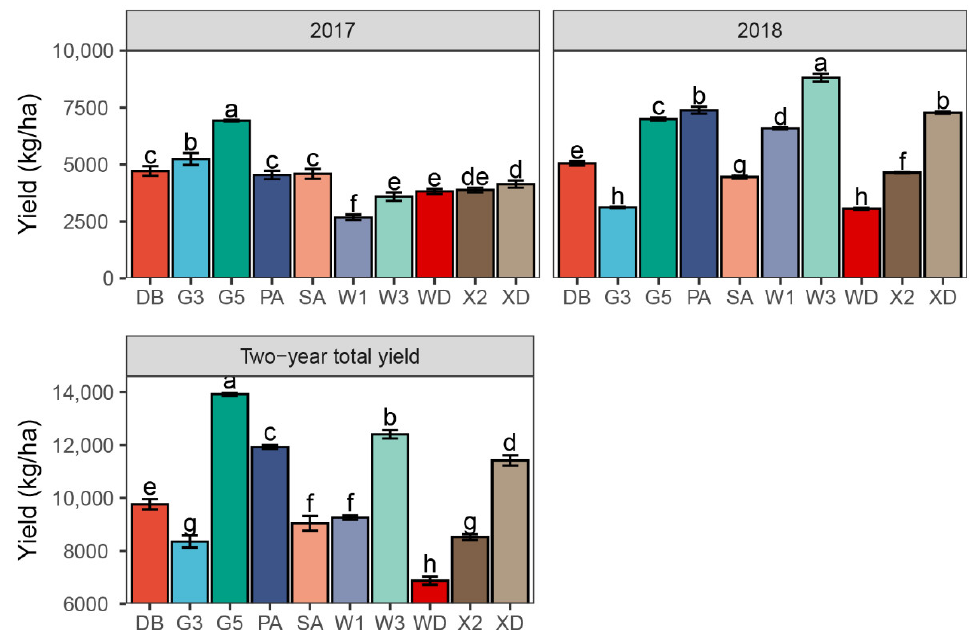
Figure 2. The annual yield of 10 alfalfa varieties in 2017 and 2018, and the two-year total yield. Different letters indicate means that are significantly different at p < 0.05. Error bars indicate the standard deviation of the means. DB: Derby, G3: Gannong No. 3, G5: Gannong No. 5, PA: Phabu-